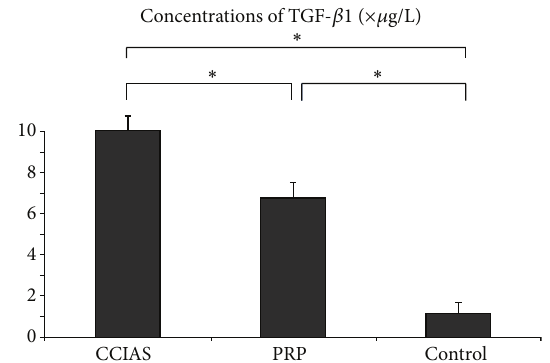
Figure 3: Concentrations of TGF- 𝛽 1 in PRP, CCIAs, and control groups. TGF- 𝛽 1 concentrations in PRP group ( 𝑛 = 6 ), CCIAs group ( 𝑛 = 6 ), and control group ( 𝑛 = 6 ) were measured. The data were expressed as the mean ± error and evaluated by one-way ANOVA. ∗ 𝑃 < 0.05 , with a statistical significance between two